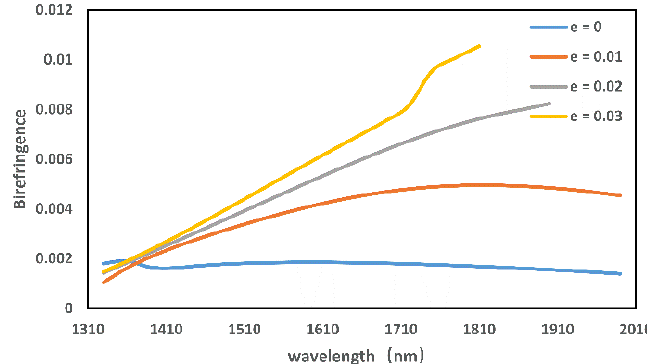
Figure 6. Effect of different germanium concentrations on birefringence.